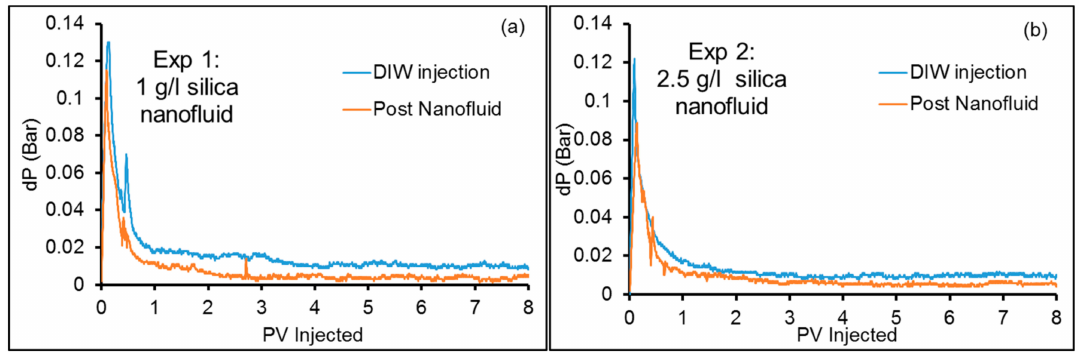
Figure 4. Pressure drop profiles for silica dispersed in deionized water (DIW) at ( a ) 1 g/L and ( b ) 2.5 g/L